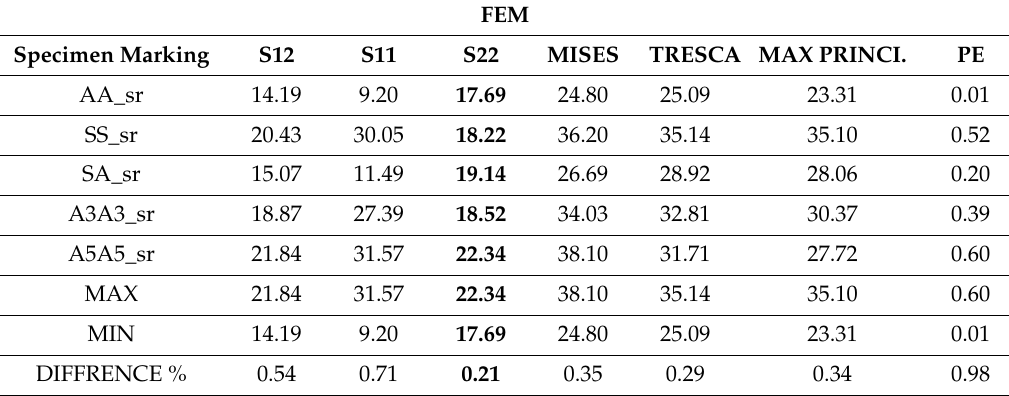
Table 9. Maximal distribution values in the adhesive middle layer on the basis of FEM.